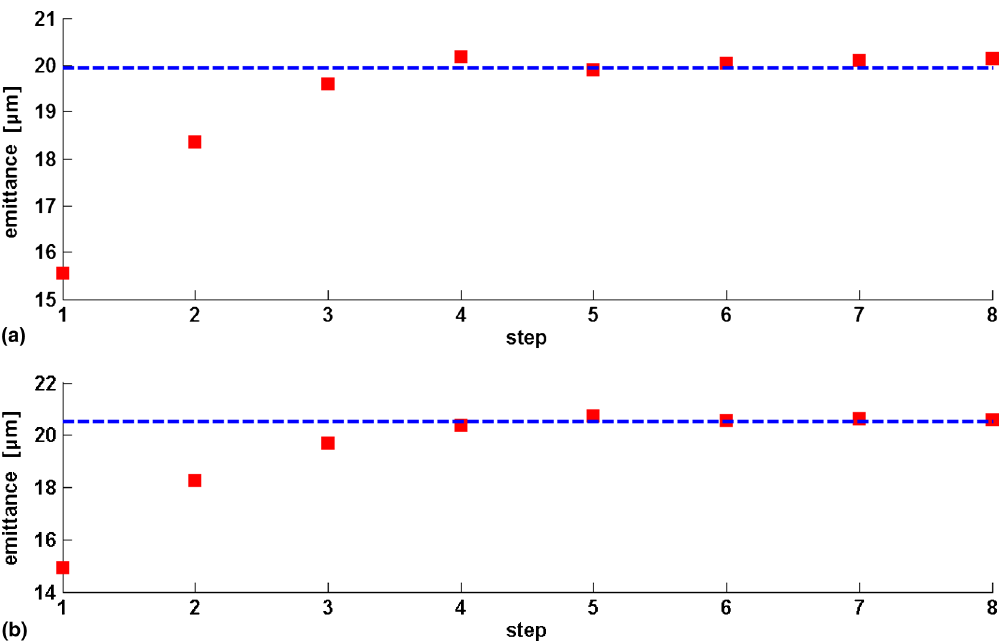
FIG. 3. Plot showing convergence of emittance for (a) a medium space-charge beam ( K ¼ 2 : 83 (cid:3) 10 (cid:1) 4 ), and (b) for a high space-charge beam ( K ¼ 7 : 06 (cid:3) 10 (cid:1) 4 ).